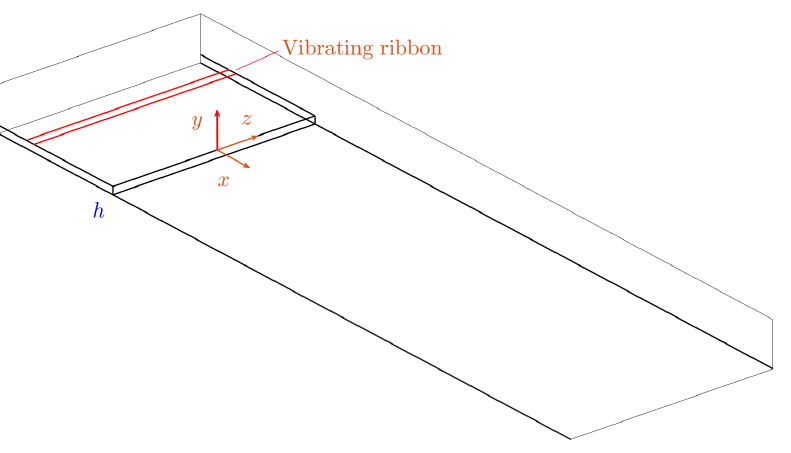
Figure 1. Sketch of the geometry used for the calculations of the boundary layer over a backward- facing